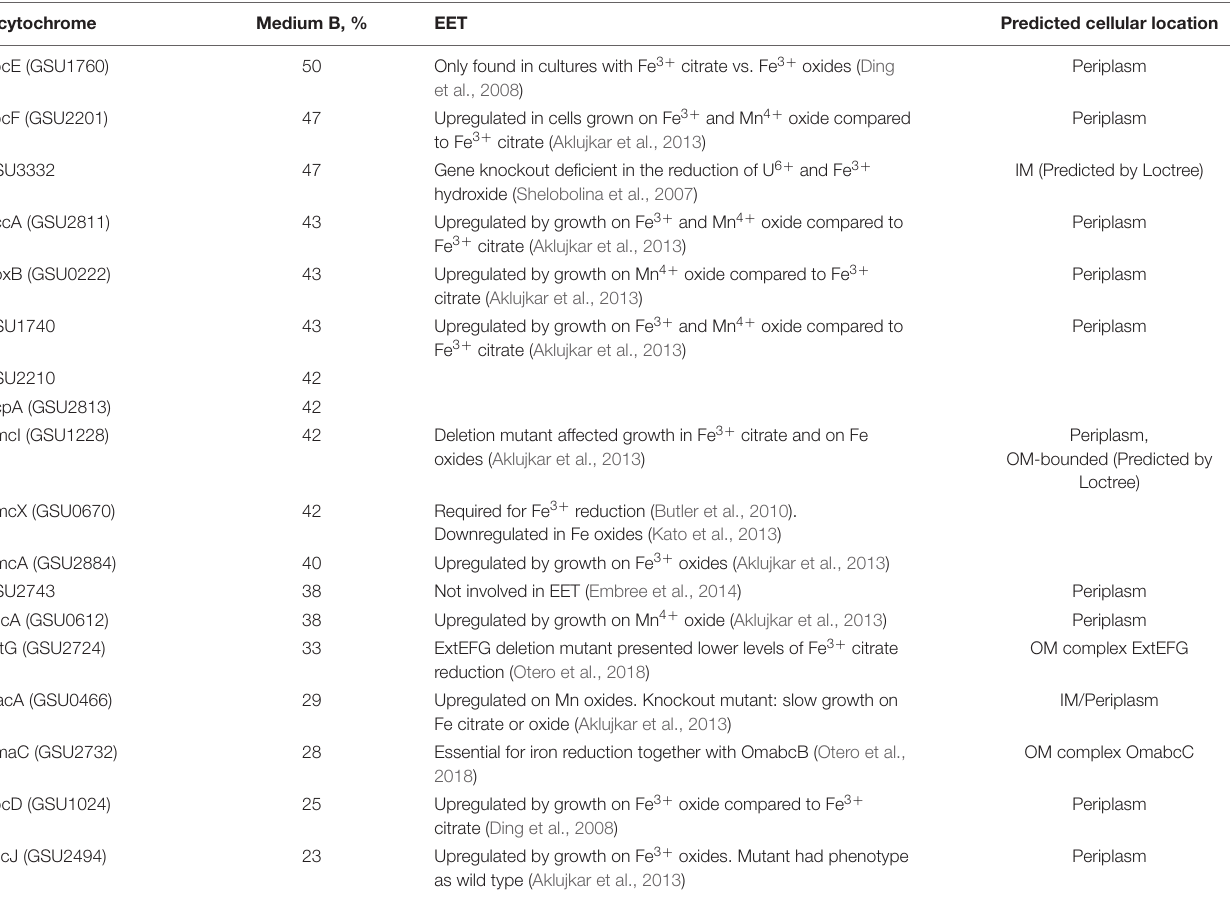
FIGURE 1 | Synthesis of Ag nanoparticles (AgNPs) during respiration of G. sulfurreducens with water soluble Ag + ions. The c -type cytochromes at the inner cell membrane (Imc), in the periplasm (Ppc), and at the outer cell membrane (Omc) transport electrons from intracellular electron donors like NADH to Ag + /Omc complexes, which leads to AgNPs, attached to the outer cell membrane (Chabert et al., 2020). In recent cell growth experiments with CrO 42 − (Gong et al., 2018), Cr 3 + reduction products could be detected within the cells, if the bacteria reacted for several hours with the chromium salts. Therefore, our reduction experiments of CrO 42 − might also occur partly inside of the cells, although the reaction conditions are different. TABLE 1 | Functions and remaining percentages of c -cytochromes that were downregulated by at least 50% during fumarate-respiring growth of G. sulfurreducens in medium B compared to growth in medium A